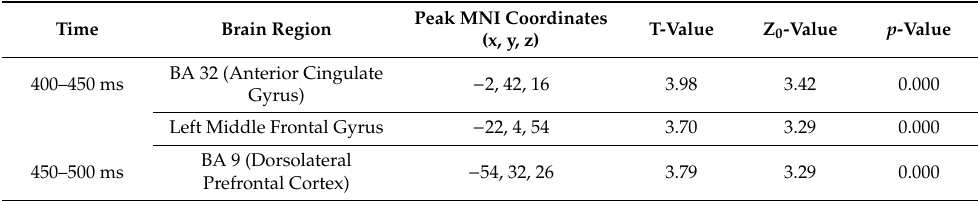
Figure 3. Source analyses revealed main switch effects around 400 ms in the left hemisphere. The first time-window (400–450 ms) showed the effect in the anterior cingulate gyrus and left middle frontal gyrus. In the second time-window, the effects were similar to those in the previous time-window in the left inferior frontal gyrus. Table 4. Main e ff ects in the two di ff erent time windows (400–450 ms and 450–500 ms) showing the regions where the e ff ect of the switch was located, their coordinates and their respective statistical values (T, Z0 and p